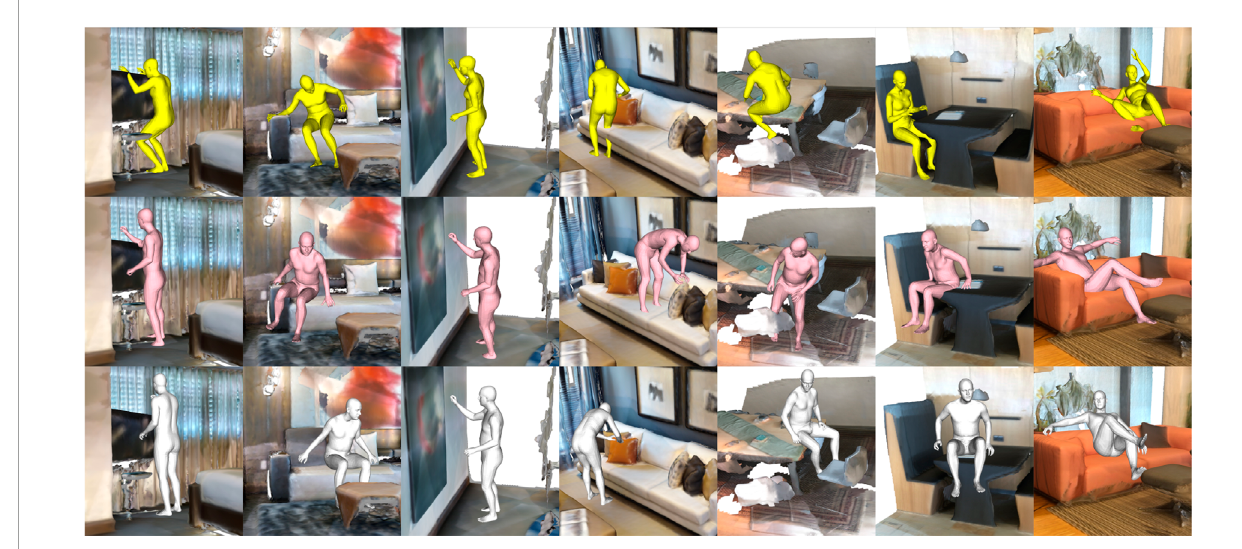
FIGURE 7 Qualitative challenging locations. PLACE (yellow), POSA (pink), and AROS (silver).